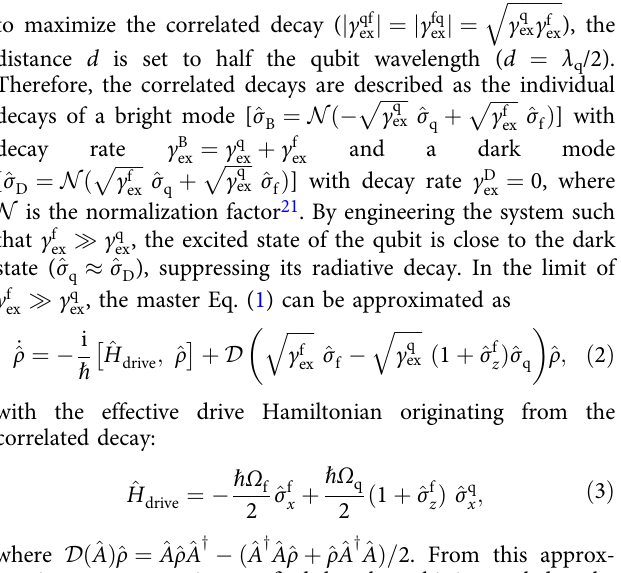
ð γ f þ γ f Þ 2 = ð 4 γ f Þ , f ex in ex